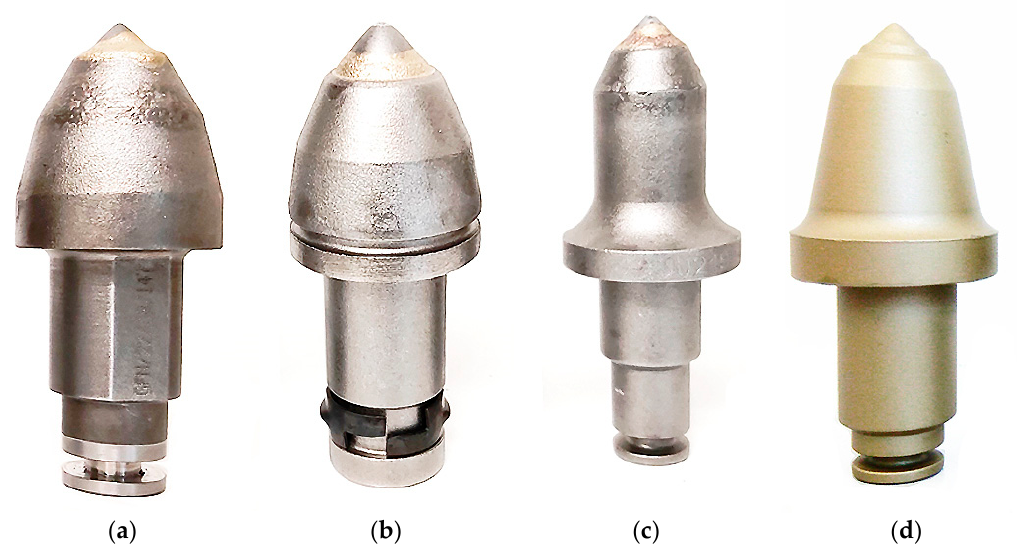
Figure 2. Compilation of picks assigned for test tip collection: ( a ) Road 1, ( b ) Road 2, ( c ) Longwall 1, ( d ) Longwall